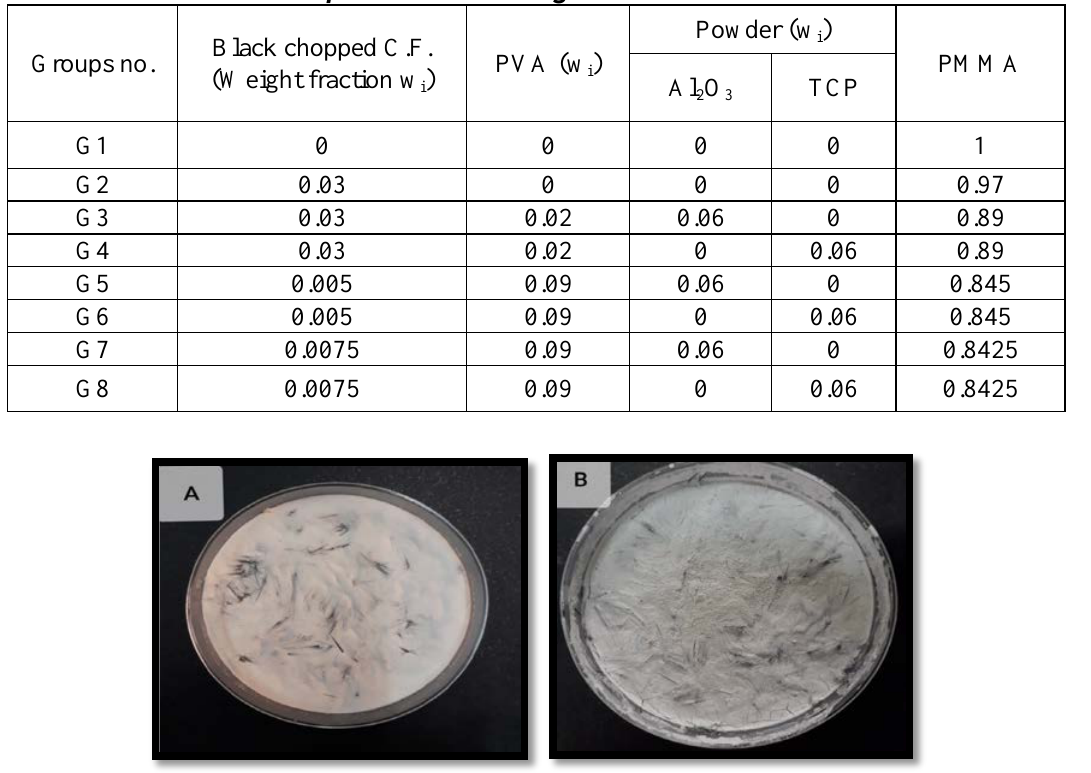
Fig. 2: Coated chopped C.F. with a) Al